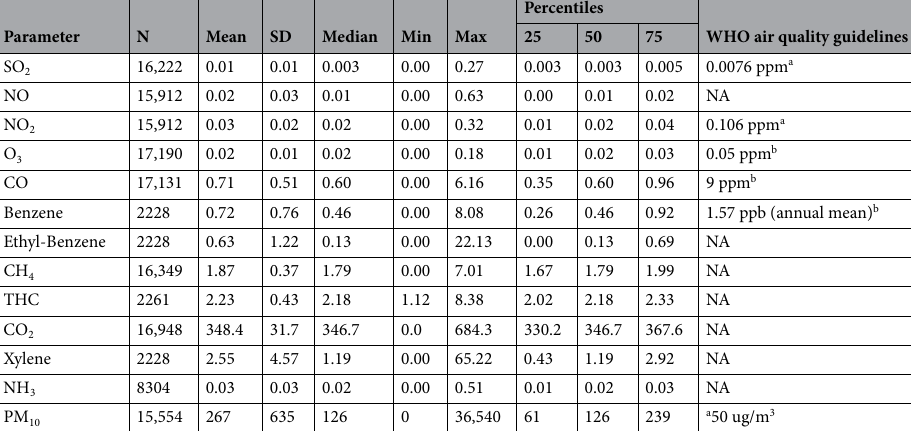
Parameter Absorption range (nm) Coefficient (β) 95% CI of β P -value *R 2